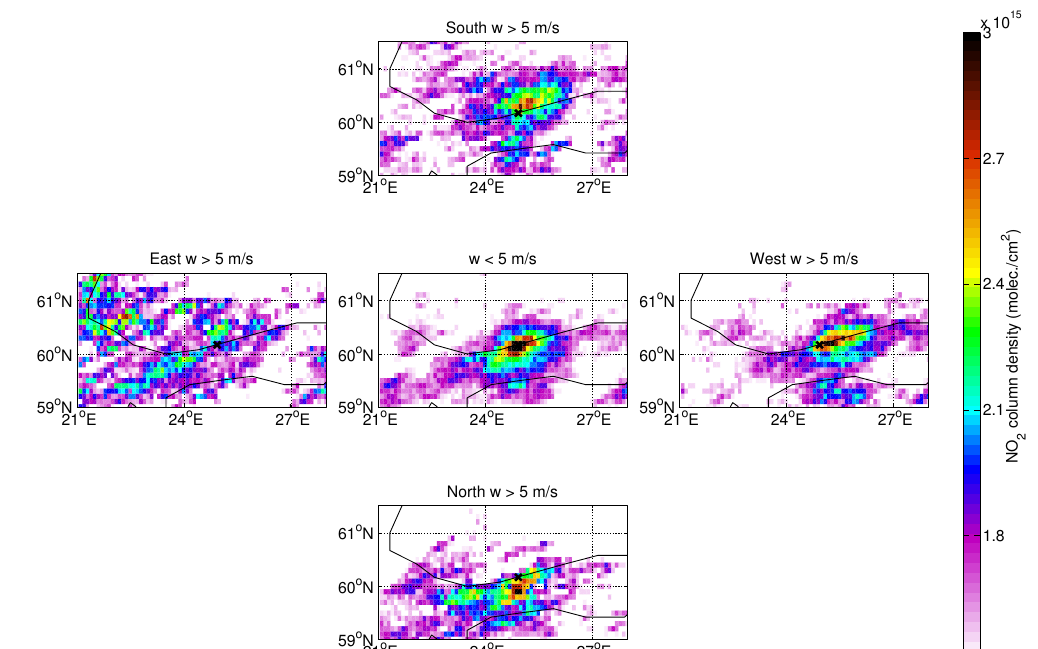
Figure 3. Summer 2005–2011 mean tropospheric NO 2 columns around Helsinki (black cross) for different wind conditions, i.e. weak wind (central panel) and four main wind direction sectors (surrounding panels). NO 2 maps for winds blowing from north, west, south and east, are respectively shown moving clockwise from the top panel.